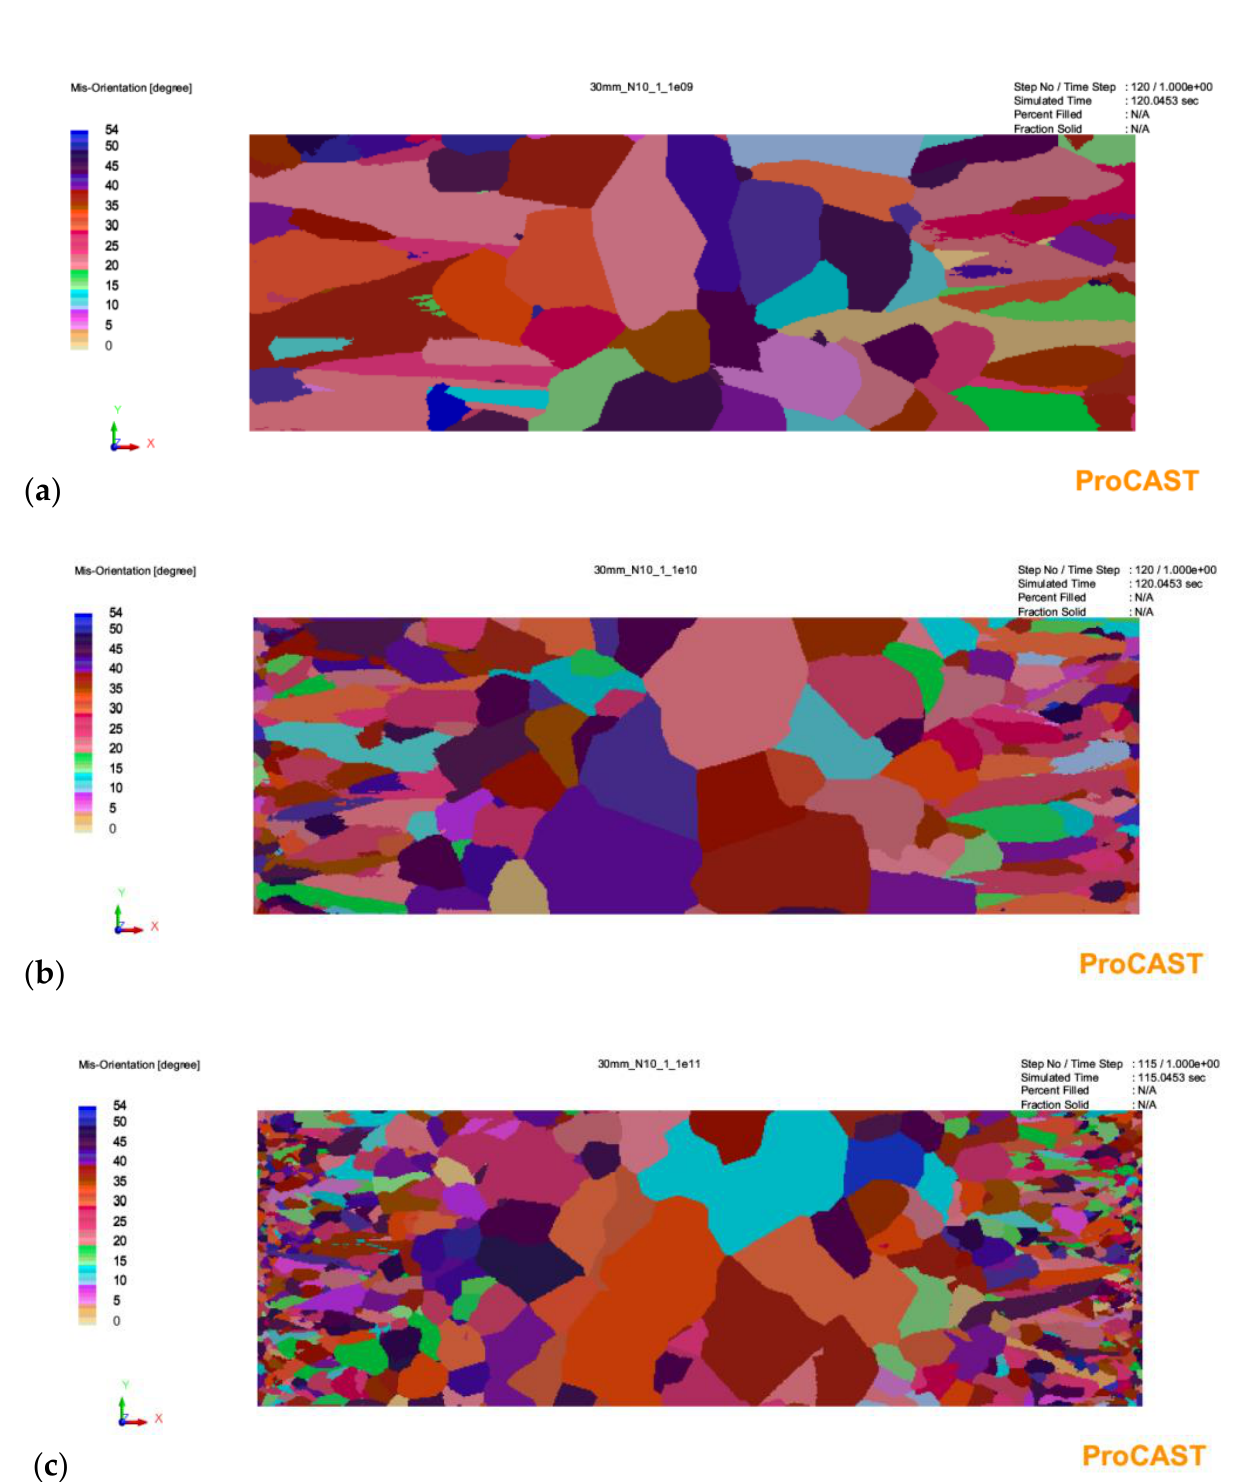
Figure 3. Simulation results for a casting wall thickness of 20 mm with a given number of austenite nucleation sites in the amount of: ( a )—10 9 ; ( b )—10 10 ; ( c )—10 11 .